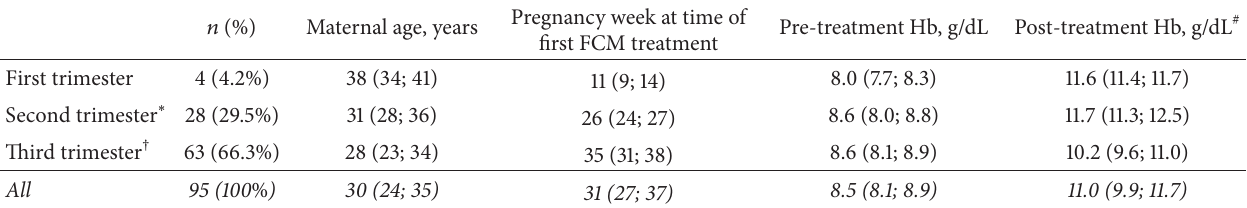
Table 1: Response to intravenous ferric